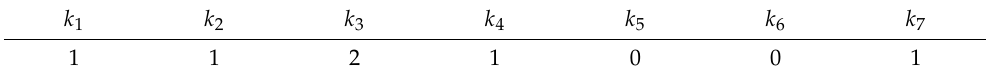
Table 3. The values of k 1 to k 7 after expanding with the consideration of linear